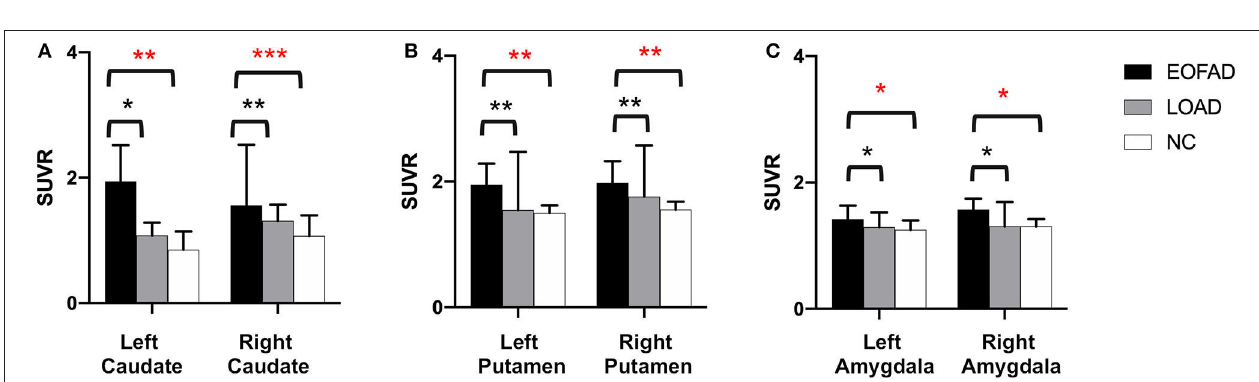
FIGURE 3 | 11 C-PIB retention among patients with EOFAD, patients with LOAD, and NC group in the striatum. There were significant SUVR differences among the three groups in caudate (A) , putamen (B) , and amygdala (C) . 11 C-PiB, 11 C-labeled Pittsburgh compound-B; EOFAD, early-onset familial Alzheimer’s disease; LOAD, late-onset Alzheimer’s disease; NC, normal control; SUVR, standardized uptake value ratio. *means P < 0.05, **means P < 0.01, and ***p <